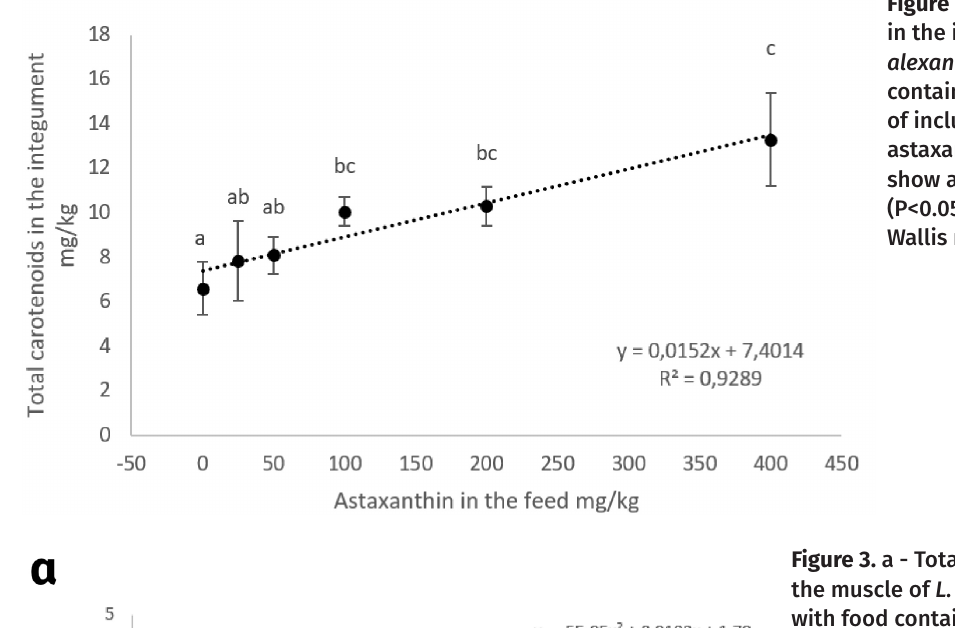
Figure 3. a - Total carotenoids in the muscle of L. alexandri fed with food containing different levels of inclusion of synthetic astaxanthin. b - Retention of total carotenoids (%) in the muscle of L. alexandri fed with food containing different levels of inclusion of synthetic astaxanthin. Different letters above the data show a significant difference (P<0.05) by the Kruskal - Wallis nonparametric